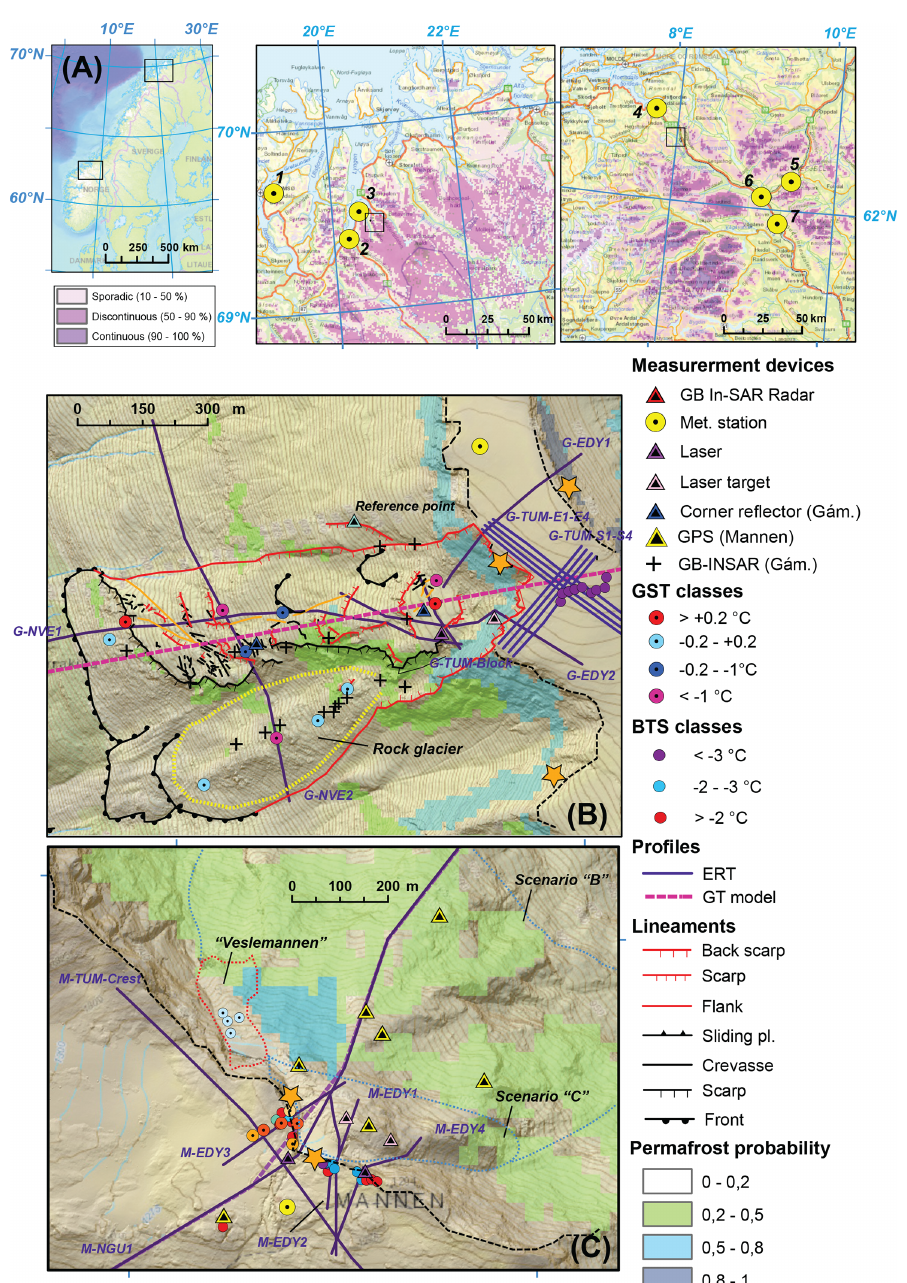
Figure 1. (a) Key map for location of the study sites. The rectangles indicate the locations of the study in southern (SN) and north- ern Norway (NN). The yellow circles show the climate stations used for the analysis of the rock wall surface temperature time series. (1) Tromsø (100ma.s.l.), (2) Skibotn (10ma.s.l.), (3) Nordnes (600ma.s.l.), (4) Åndalsnes (16ma.s.l.), (5) Fokkstua (950ma.s.l.), (6) Dombås (650ma.s.l.), (7) Dovre (450ma.s.l.). (b) Overview map of the Gámanjunni-3 unstable area. The point symbols show measurement devices or selected points for time series extraction used in this study. The yellow stippled line denotes the outline of the rock-glacier-like landform. (c) Overview map of the Mannen unstable area. The red stippled line denotes Veslemannen as part of the Mannen instability. The failure scenarios are taken from Kristensen et al. (2021). The point symbols show measurement devices or selected points for time series extraction used in this paper. Permafrost probabilities are based on the Cryowall map of permafrost in steep slopes by Magnin et al. (2019). The dashed black line marks the crest outlining the plateaus. The orange stars indicate the location of the rock wall loggers. Base maps from © Statens Kartverk. GST: mean ground surface temperature. BTS: bottom temperature of snow (see main text).